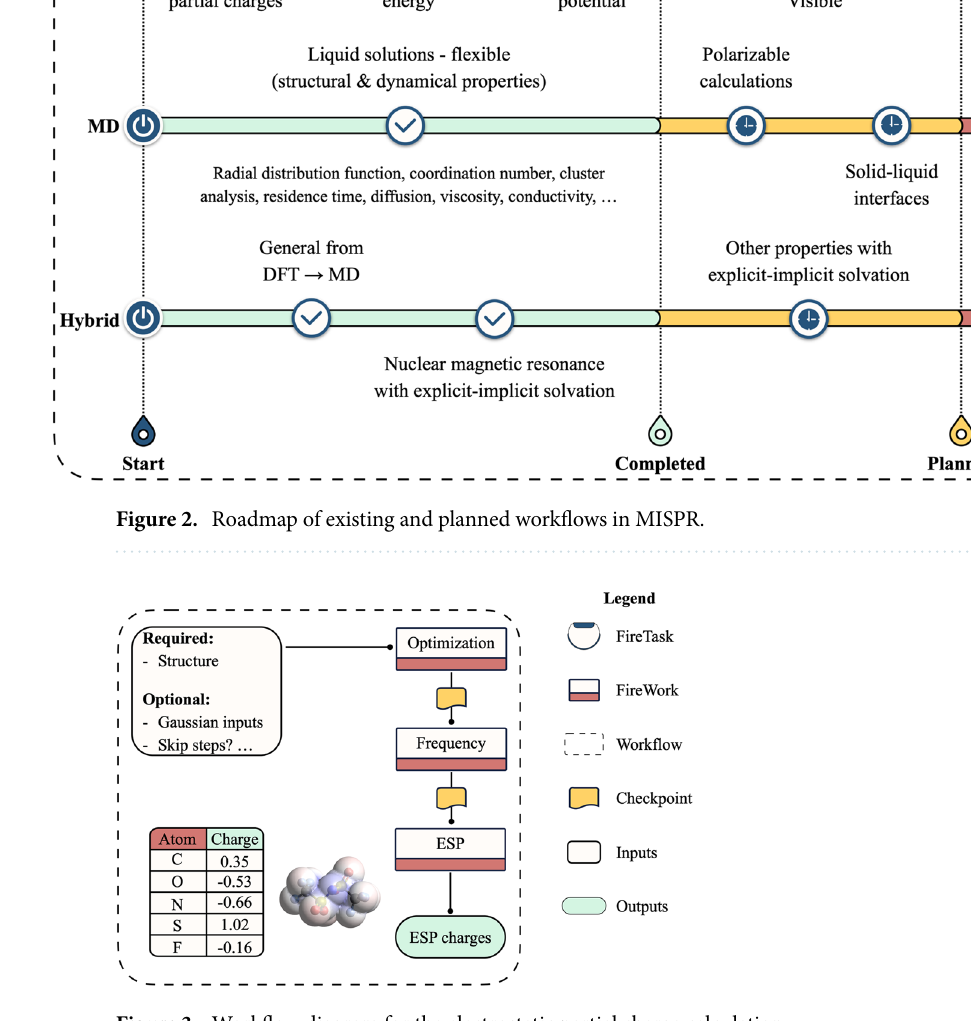
Figure 3. Workflow diagram for the electrostatic partial charge